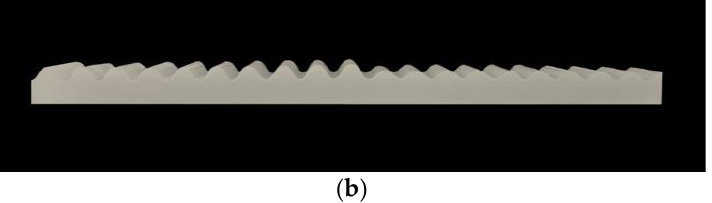
/ H of 7.0 × 10 − 2 and f s